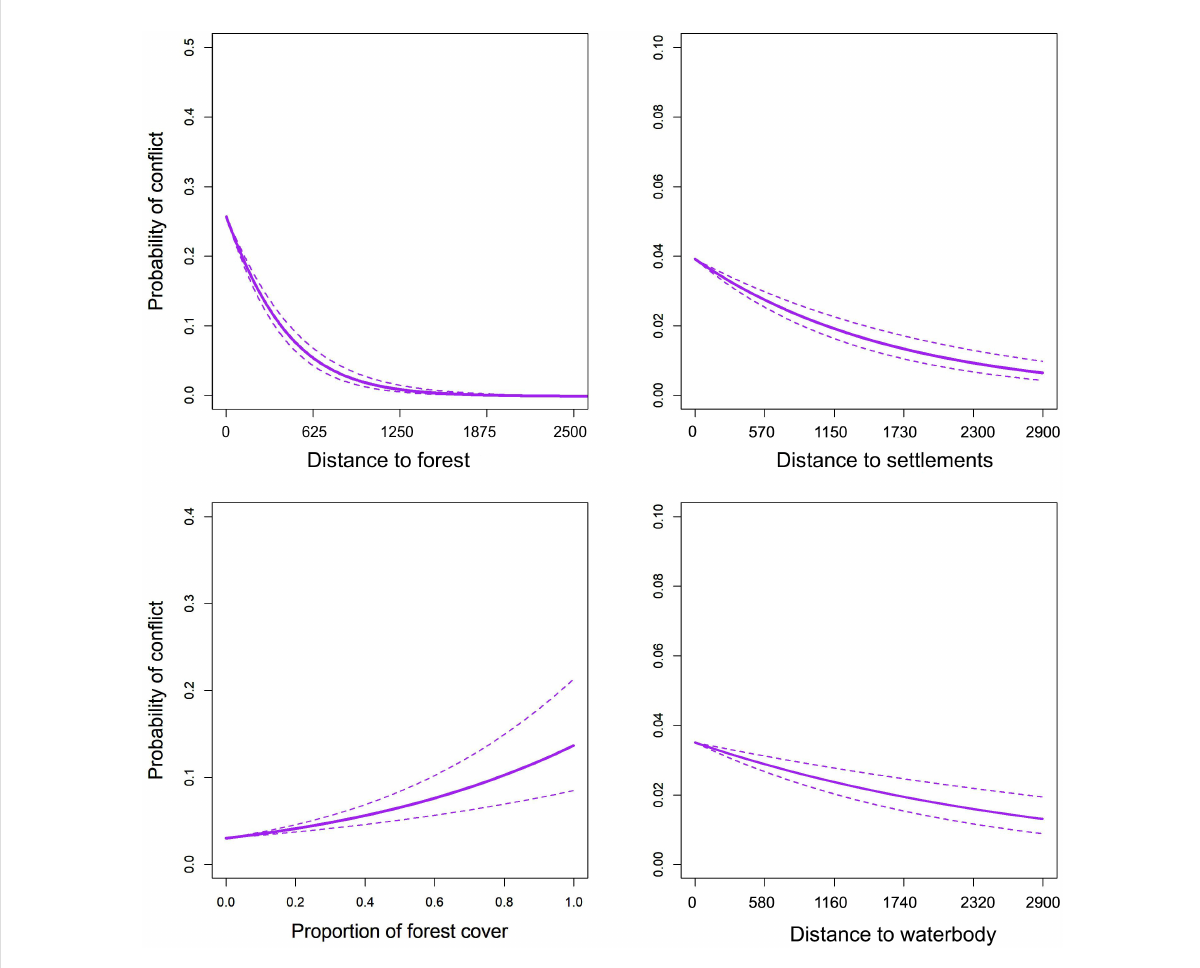
FIGURE 3 Relationships between the probability of tiger attacks on humans and predictors estimated from the averaged model. The dotted line represents a 95% con fi dence interval and the solid line is a relationship curve estimated from the model. Distances are given in